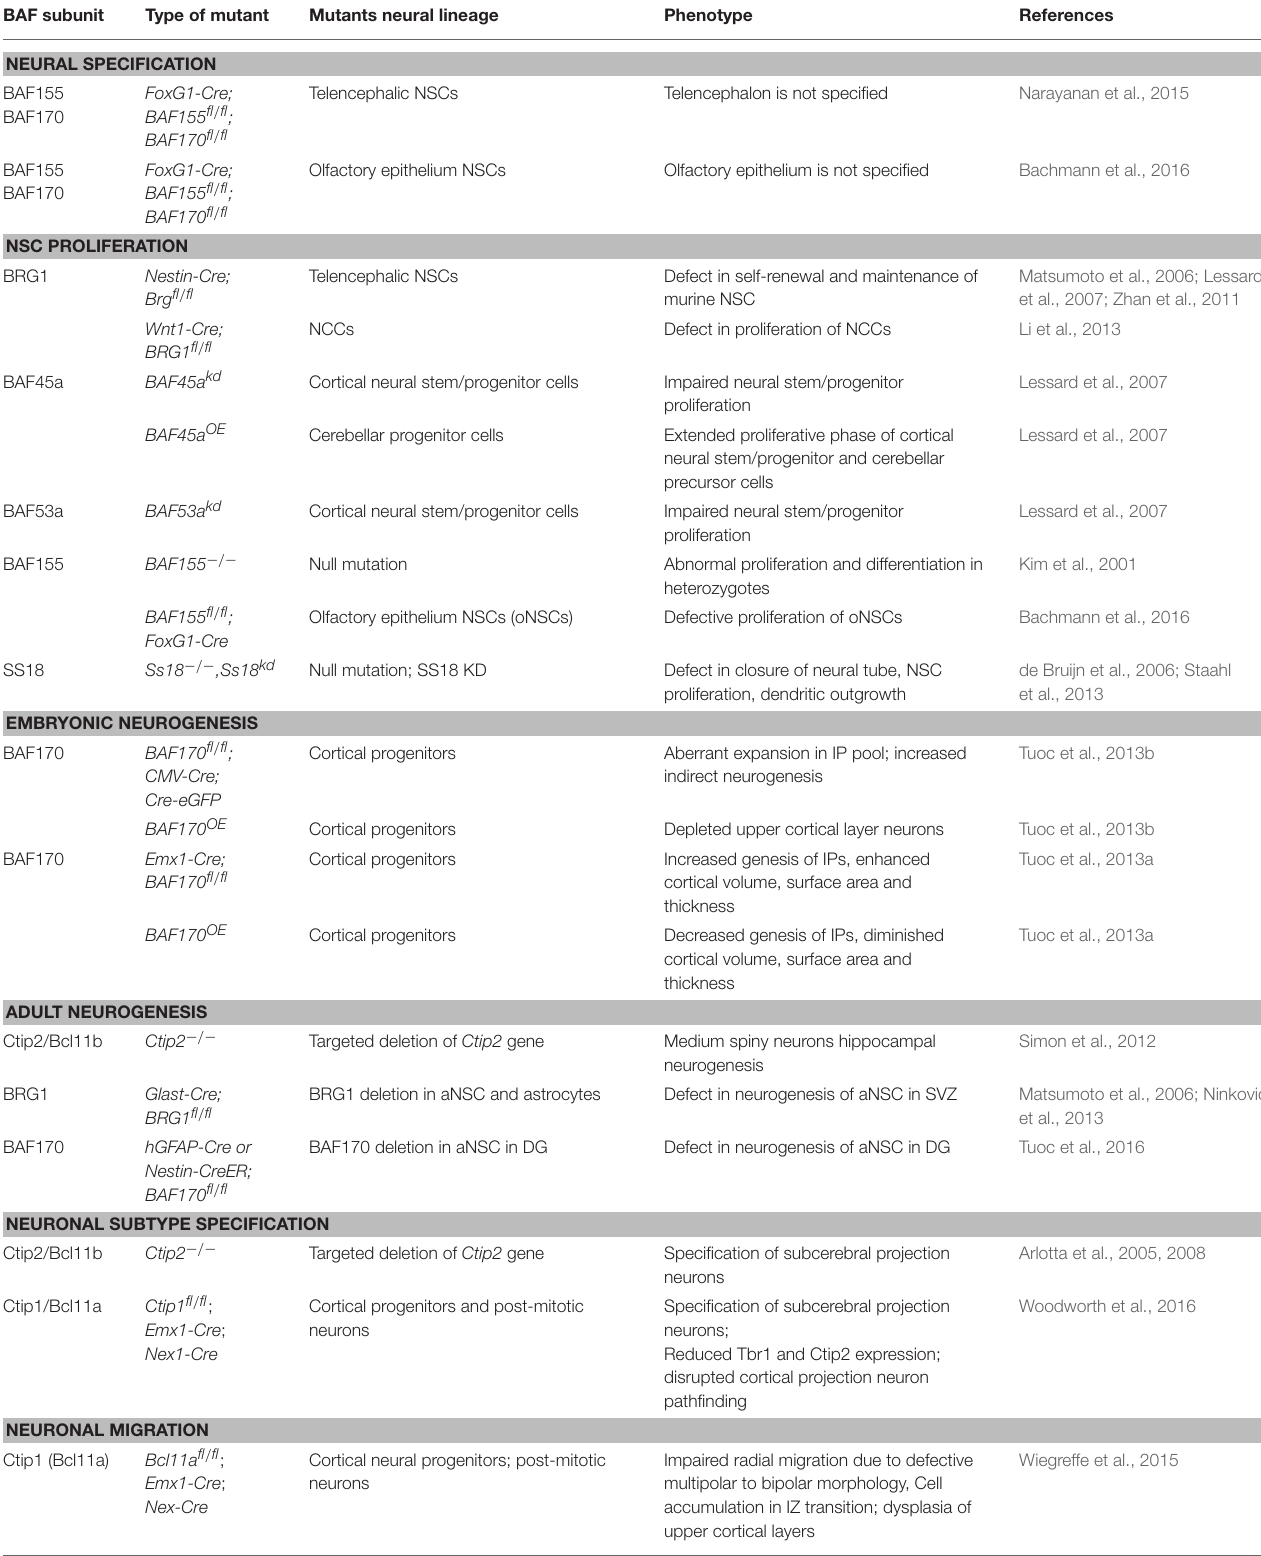
TABLE 1 | BAF subunits and their role in aspects of neural